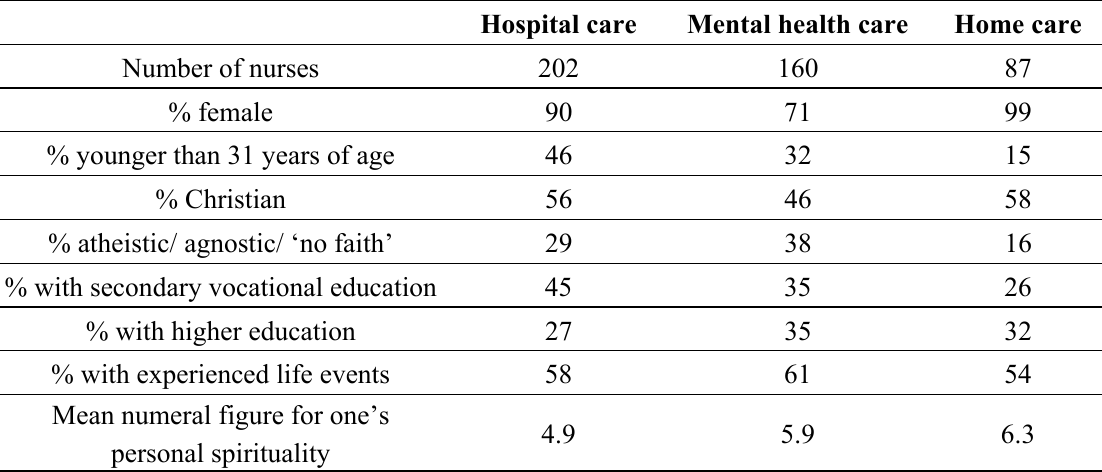
Table 1. Characteristics of nurses.